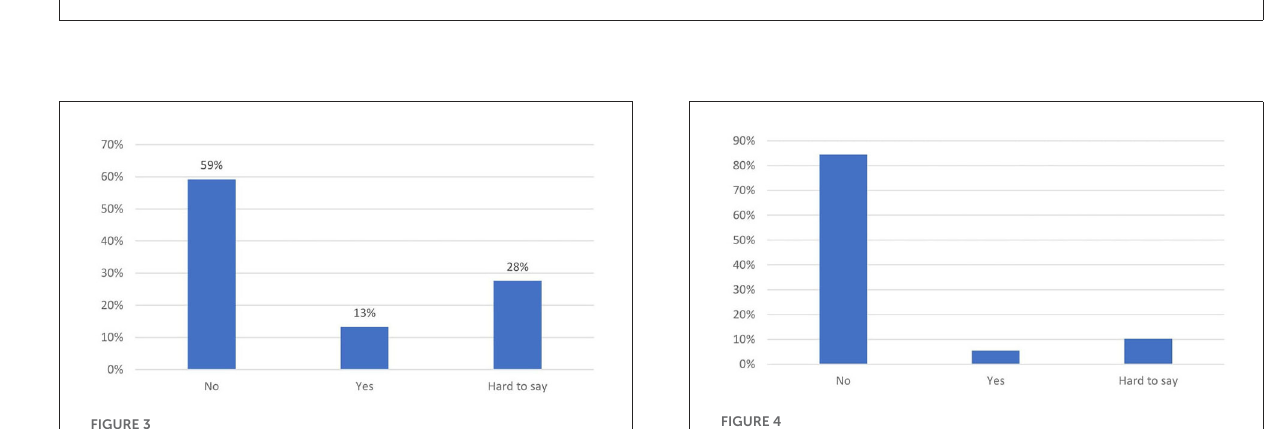
FIGURE4 Have you been appreciated by the rulers? ( N = 294).